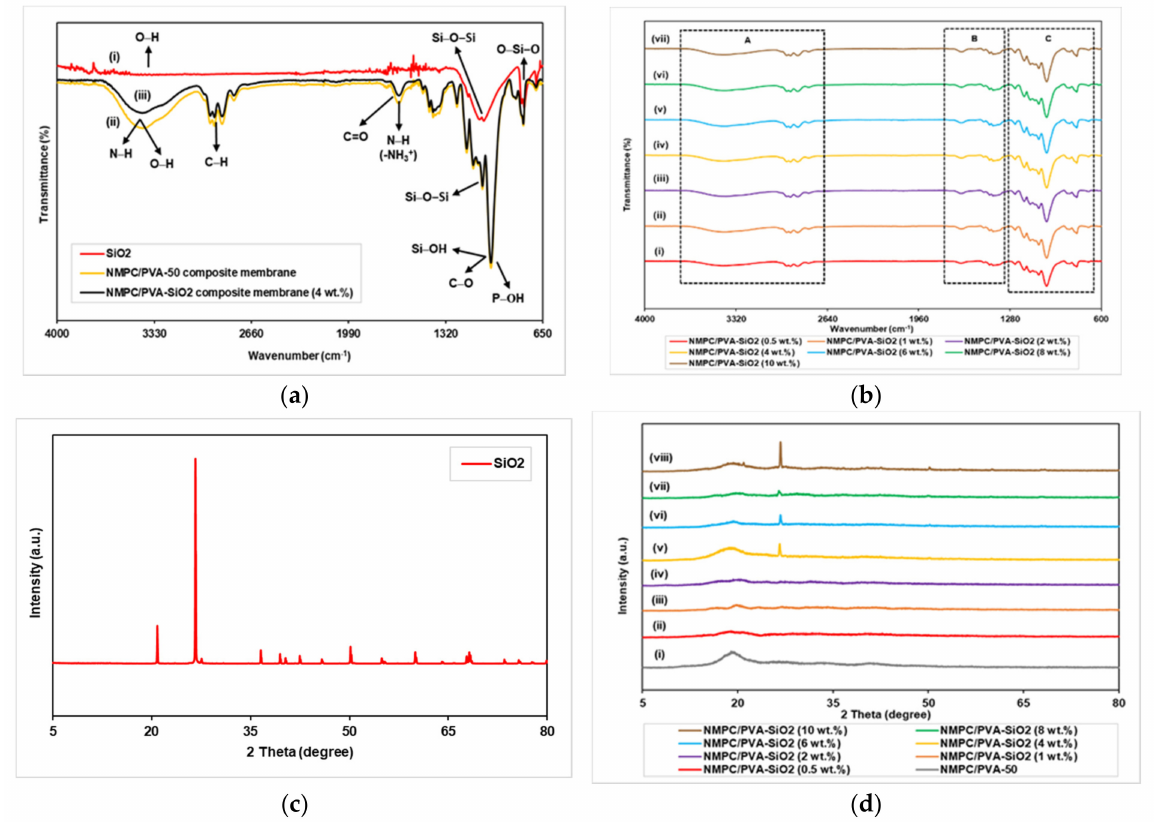
Figure 7. ( a ) FTIR spectra of SiO 2 filler, NMPC/PVA-50 and NMPC/PVA-SiO 2 (4 wt.%) composite membrane, ( b ) FTIR spectra of NMPC/PVA-SiO 2 composite membrane with different compositions, ( c ) XRD spectrum of commercial SiO 2 filler obtained experimentally, and ( d ) XRD spectra of NMPC/PVA and NMPC/PVA-SiO 2 composite membrane with different